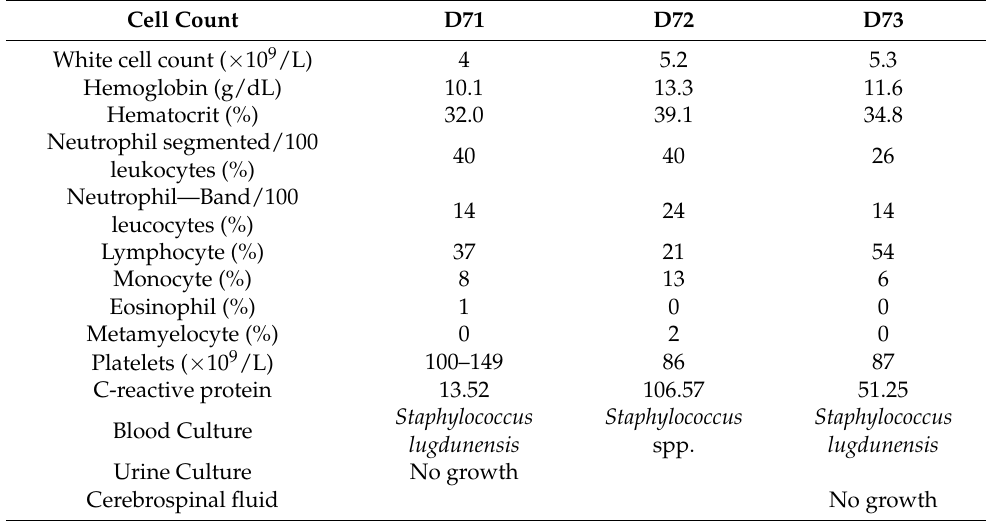
Table 1. Laboratory results of sepsis evaluation at the time of presentation of the clinical illness.